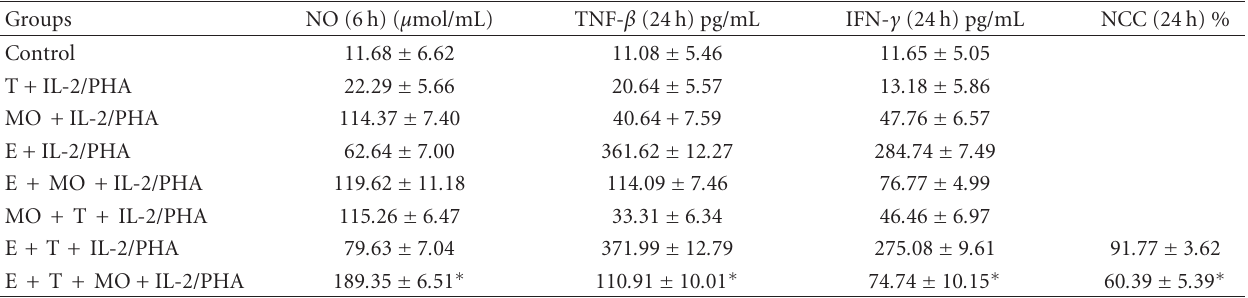
Table 3: The e ff ect of endogenous RNM on the activity of NK cells.